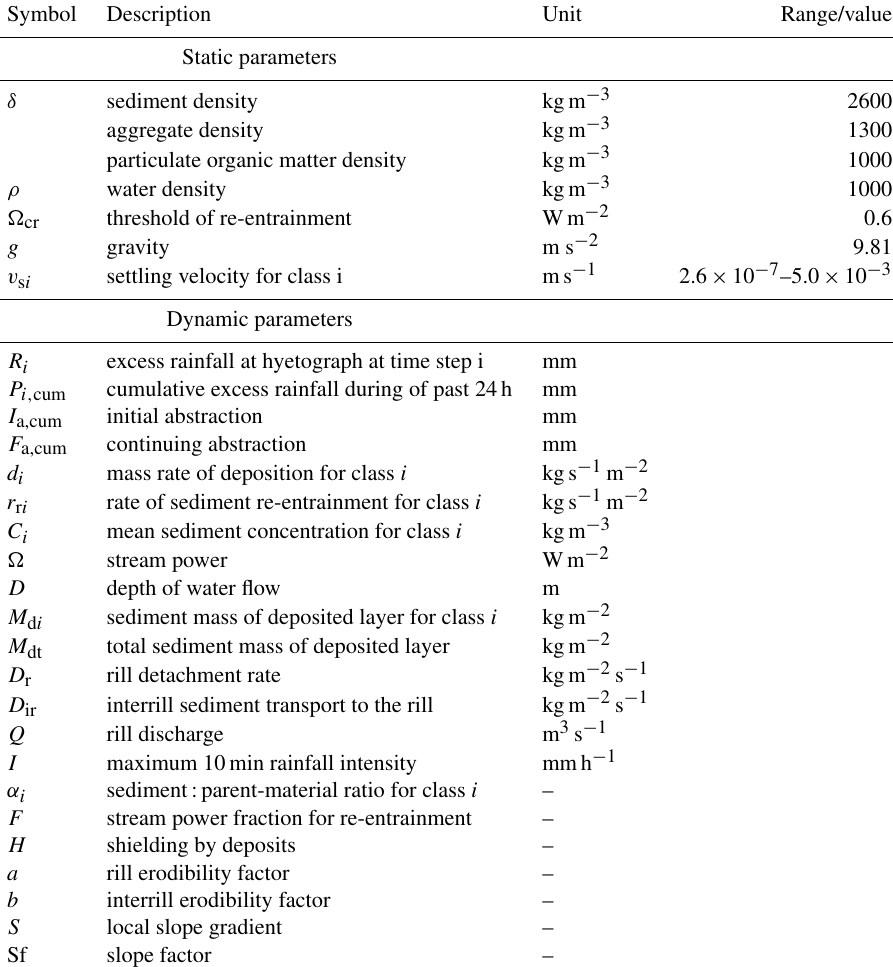
Table 1. Parameter description and model